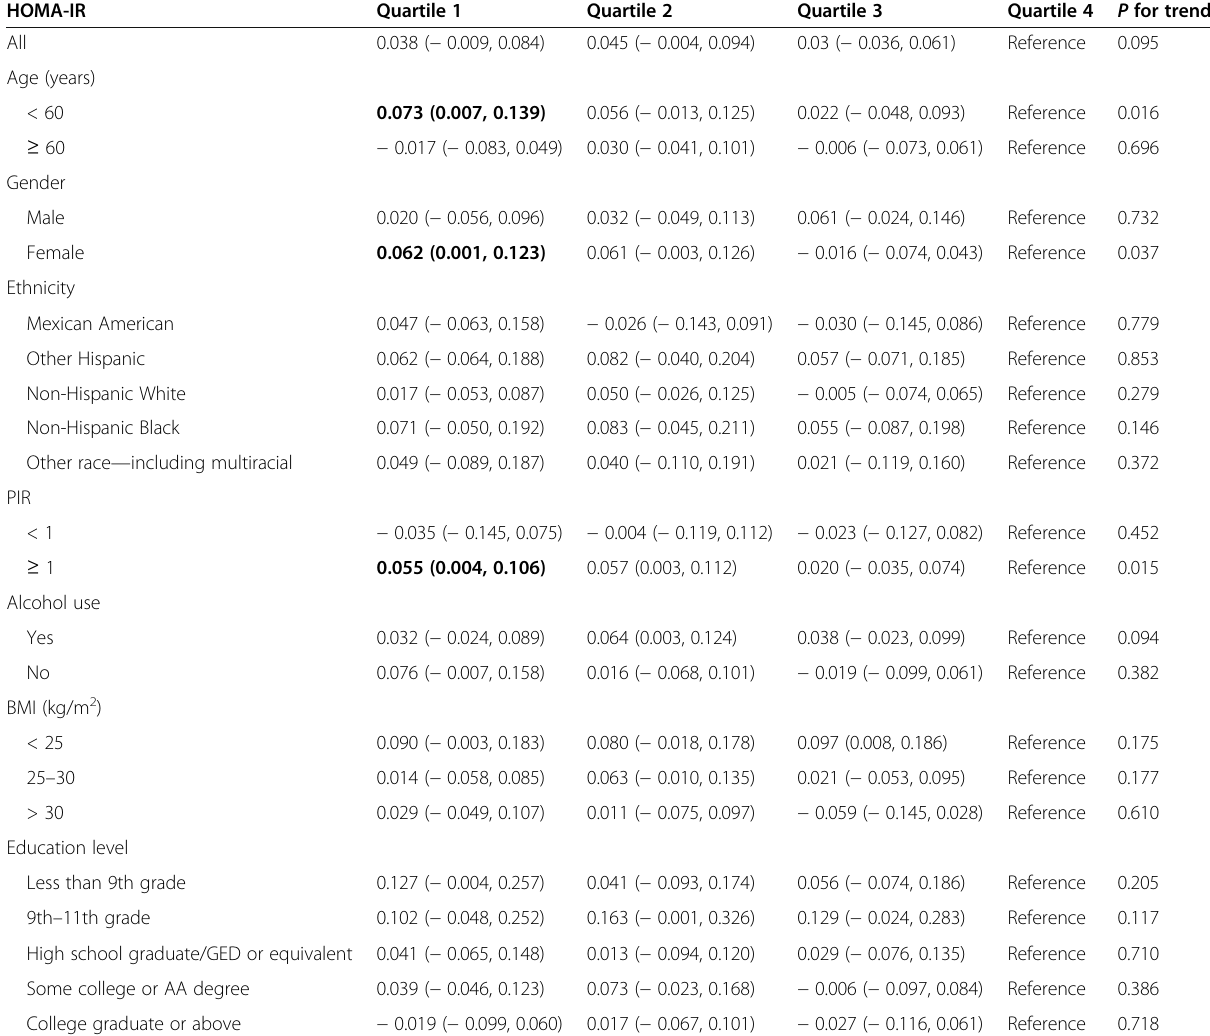
Table 3 Estimated coefficient (beta) and 95% confidence intervals (95% CI) of HOMA-IR in US adults during 2015 – 2016 for each quartile increase in blood cobalt levels stratified by different covariates HOMA-IR Quartile